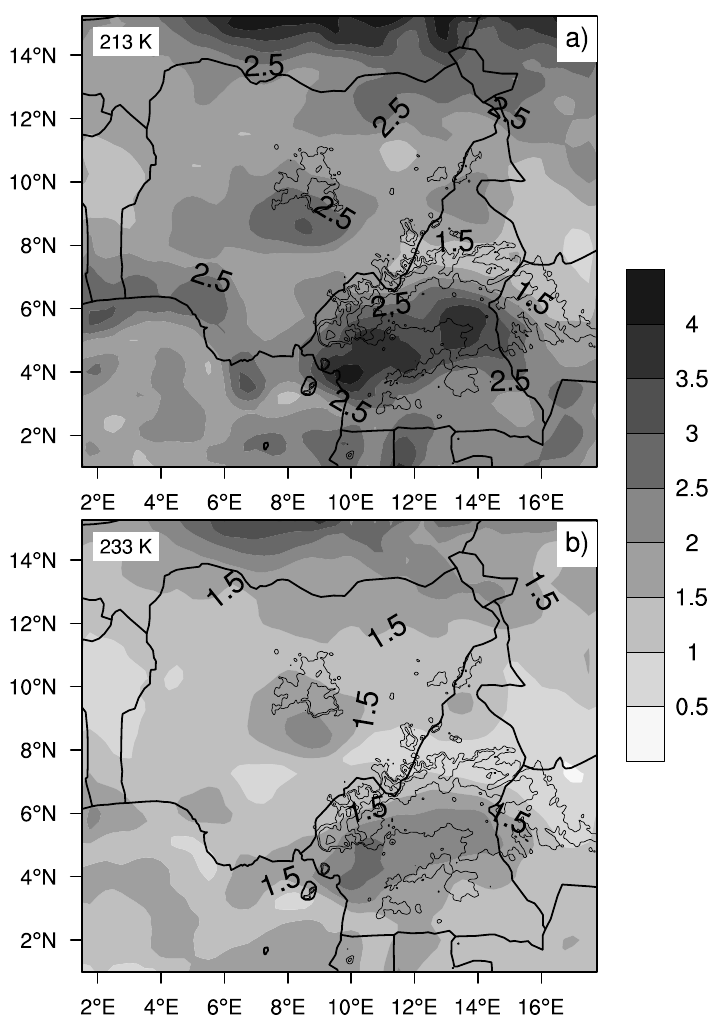
Figure 6. Mean seasonal spatial distribution of the standard deviation of the half-hour cloud fraction over the whole region of the study for June–August 1998–2002 computed for a threshold of 213 K ( a ) and 233 K ( b ). Thin lines mark terrain elevation of 700, 1,000 and 1,500